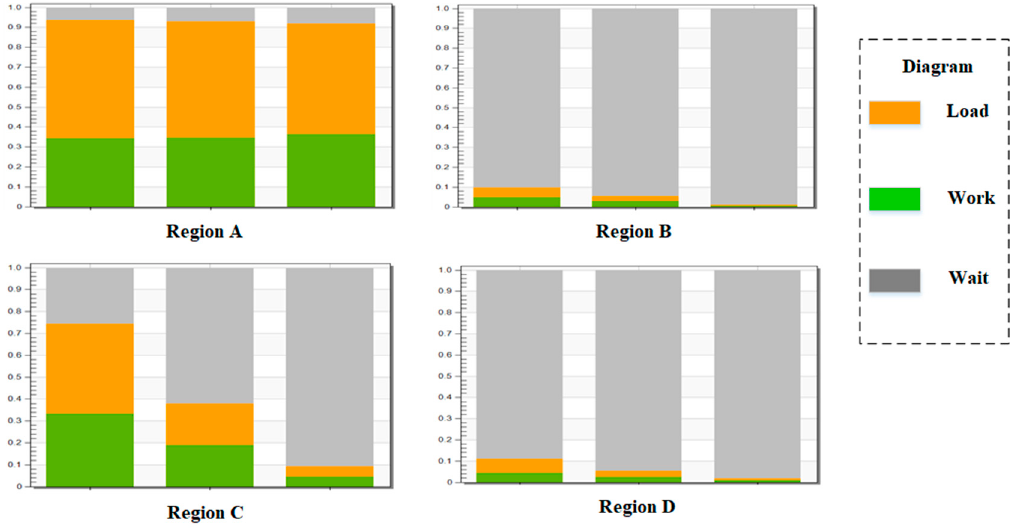
Figure 17. AGV Utilization comparison.